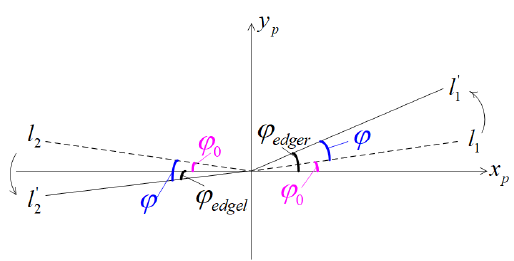
Figure 6. Relationship between yaw and straight line